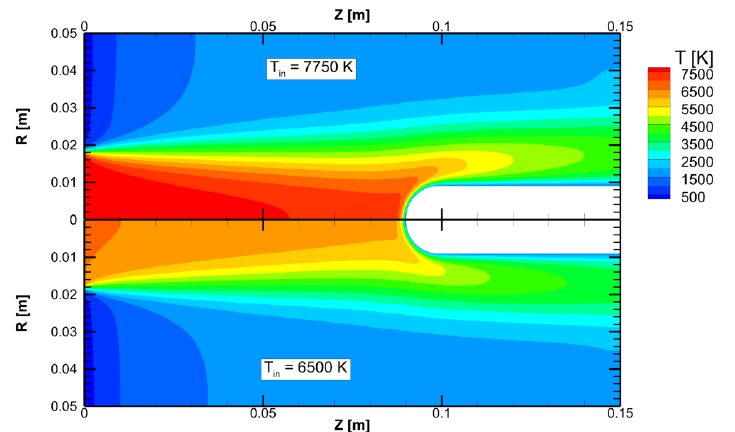
Figure 5. Temperature fields for the minimum and maximum inlet temperature cases (1 and 6)